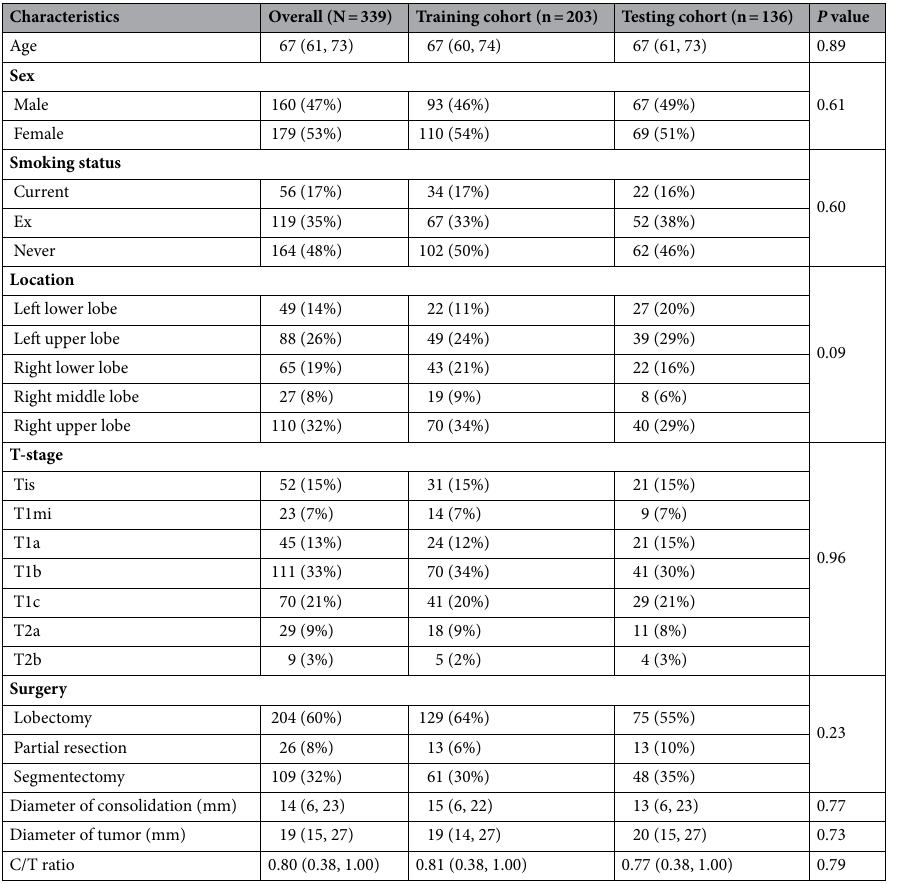
Table 1. Patient characteristics. Values are presented in median (interquartile range) or number (percentage). C/T ratio consolidation/tumor